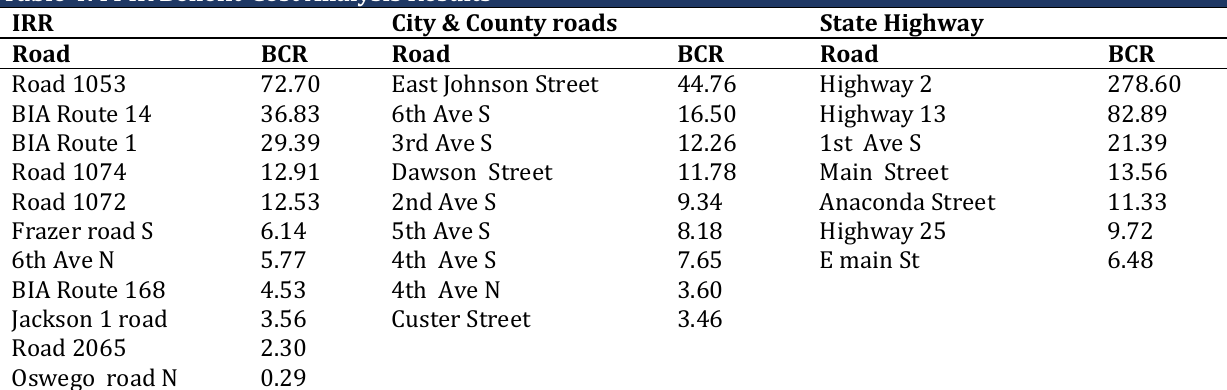
Table 4: FPIR Benefit-Cost Analysis